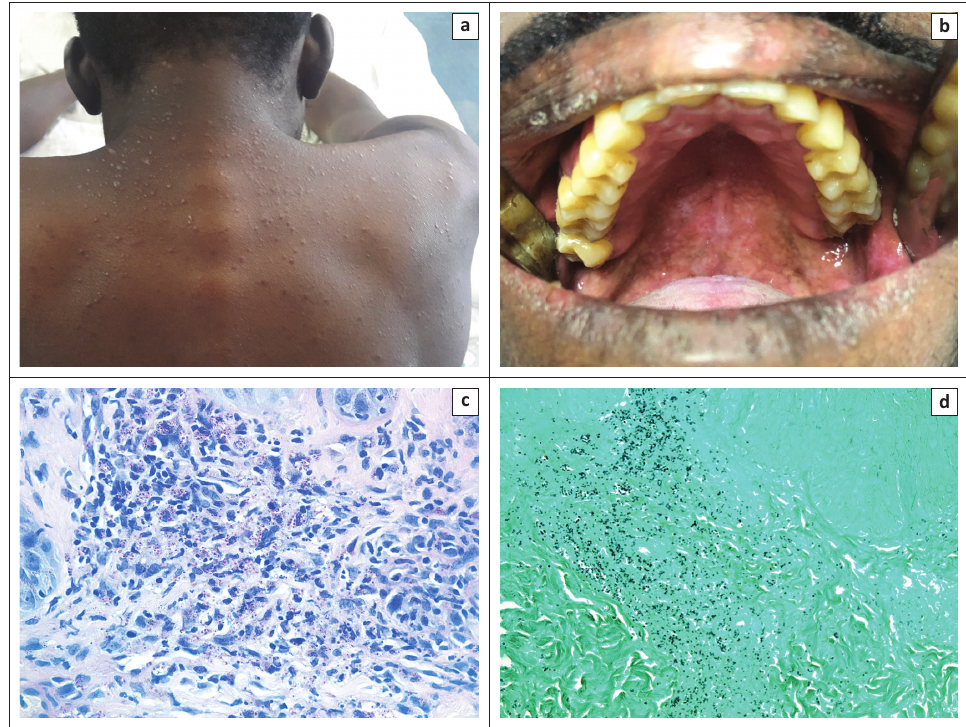
FIGURE 1: (a) Erythematous to flesh-coloured papules on the trunk; (b) Granular-appearing, pigmented lesions involving the hard and soft palate; (c) PAS-D and (d) Grocott-Gomori stained sections highlighting the intracytoplasmic organisms (original magnification ×